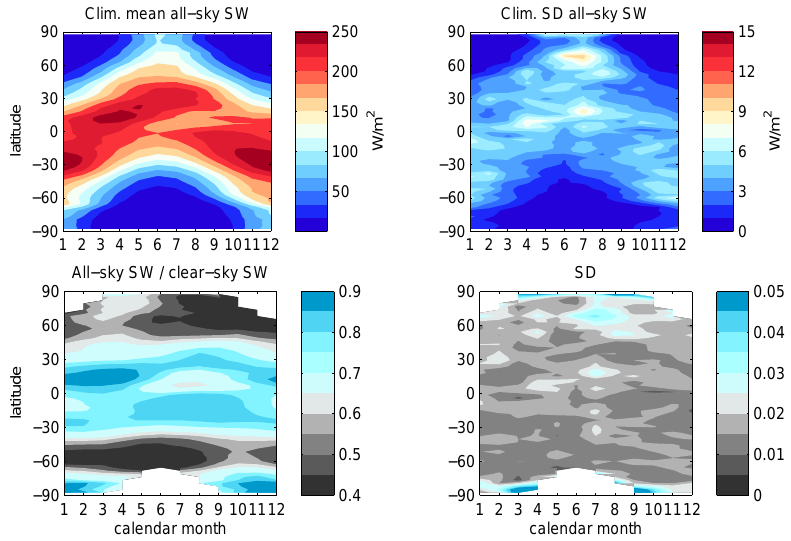
Fig. 4. MAECHAM5-HAM climatological mean, zonal mean values of all-sky SW surface radiation (top) and ratio of all-sky to clear-sky SW surface radiation (bottom) along with the interannual variability of each zonal mean field quantified by the standard deviation (SD).